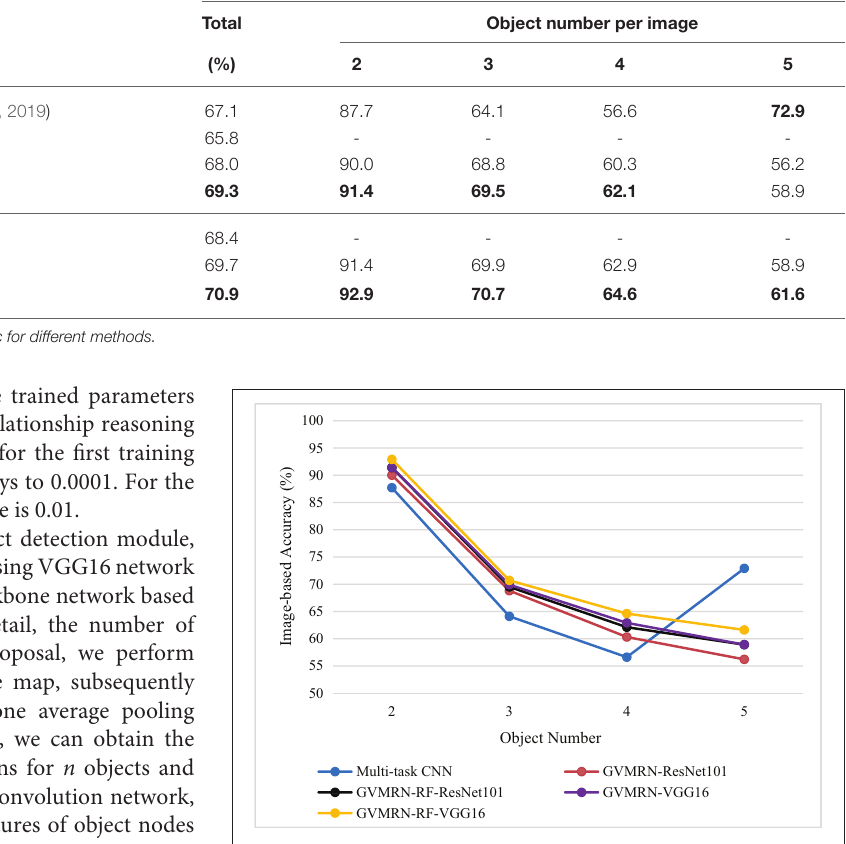
FIGURE 4 | Image-based accuracy (IA) for different number of stacked objects.